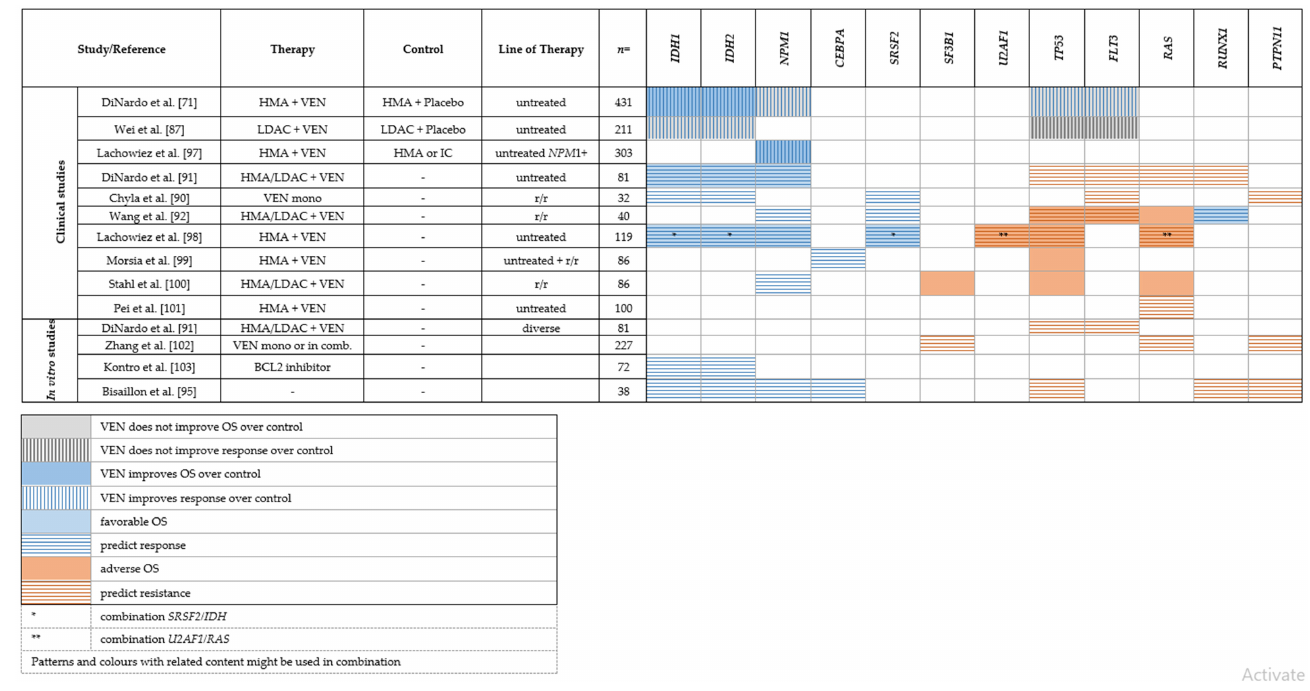
Cancers 2022 , 13 , x FOR PEER Table 3. Mutations associated with response or resistance to venetoclax.